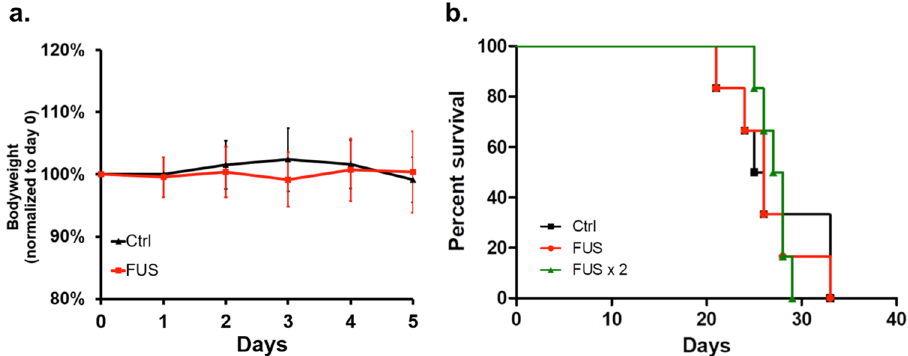
Figure 4. ( a ) Bodyweight of control animals and FUS-treated animals during the five-day post-treatment period. No significant weight loss was observed. ( b ) Kaplan–Meier curve reveals no significant difference between the survival of control mice (n = 6) with FUS (n = 6) ( p = 0.8037), and double-FUS treated mice (n = 6) ( P = 0.9399).